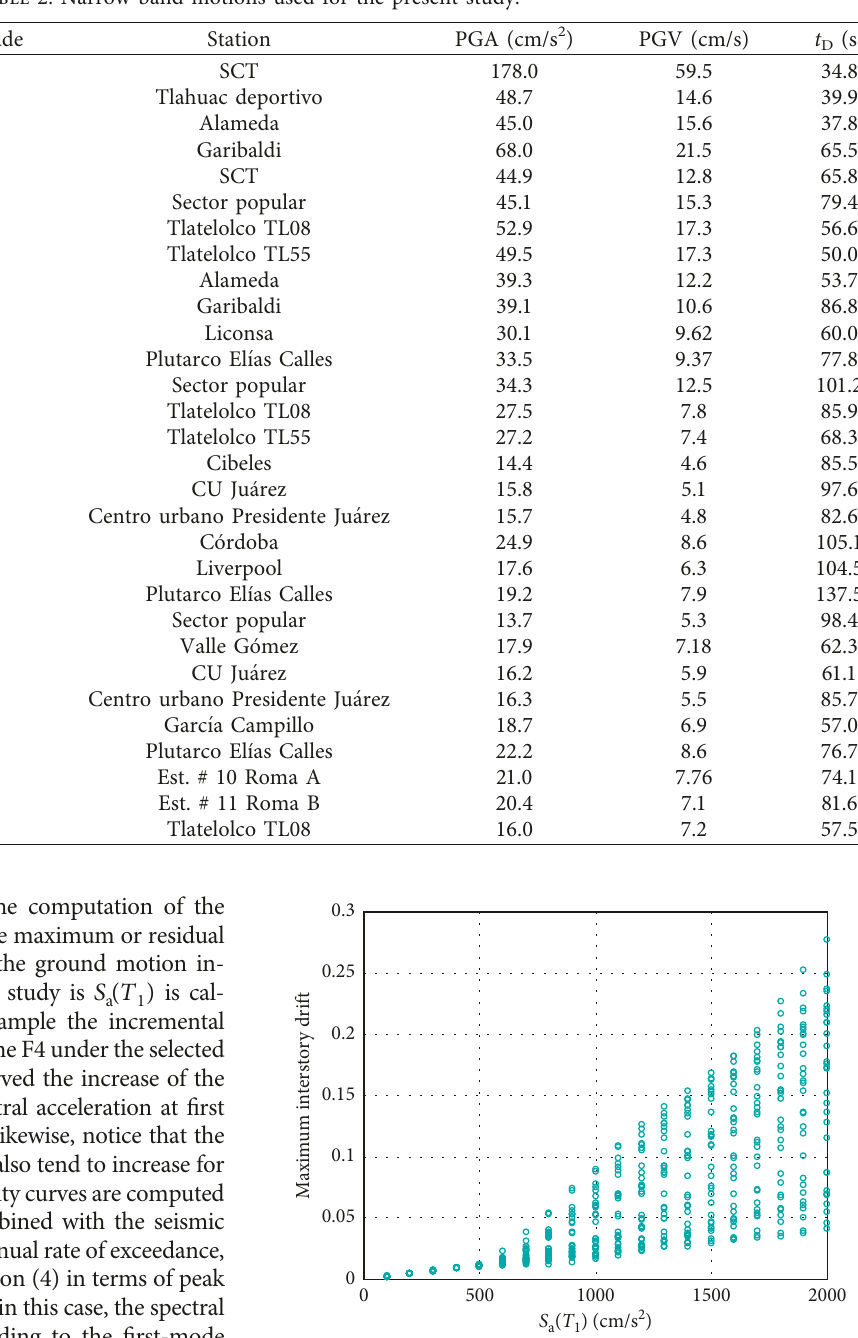
Figure 4: Incremental dynamic analysis of frame